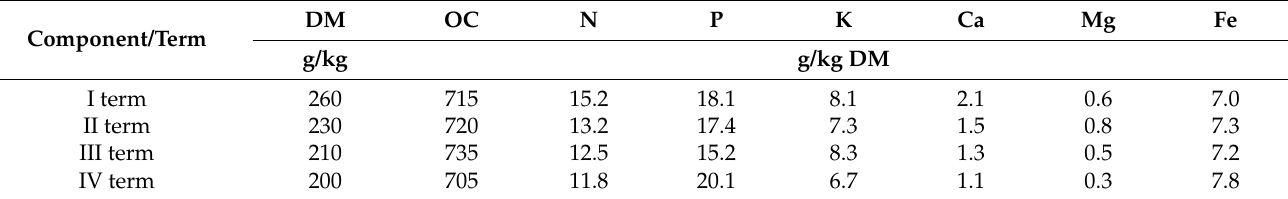
Table 2. The physicochemical composition of the digestate.